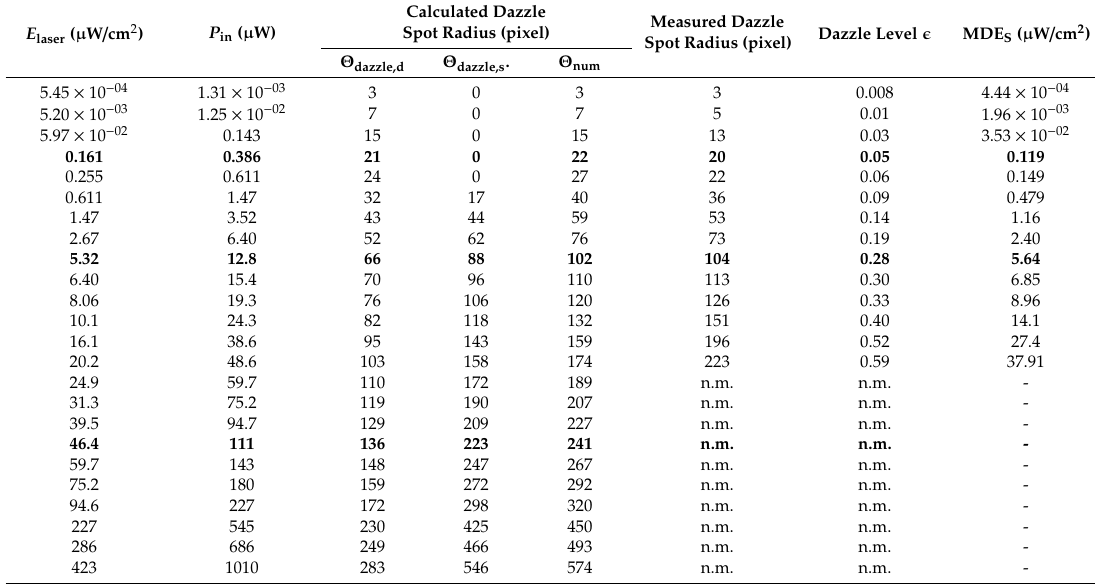
Table A3. Calculated and measured dazzle spot size using Setup 1 (see Section 6.2) for a laser wavelength of 640 nm. Abbreviation: n.m.: not measurable.